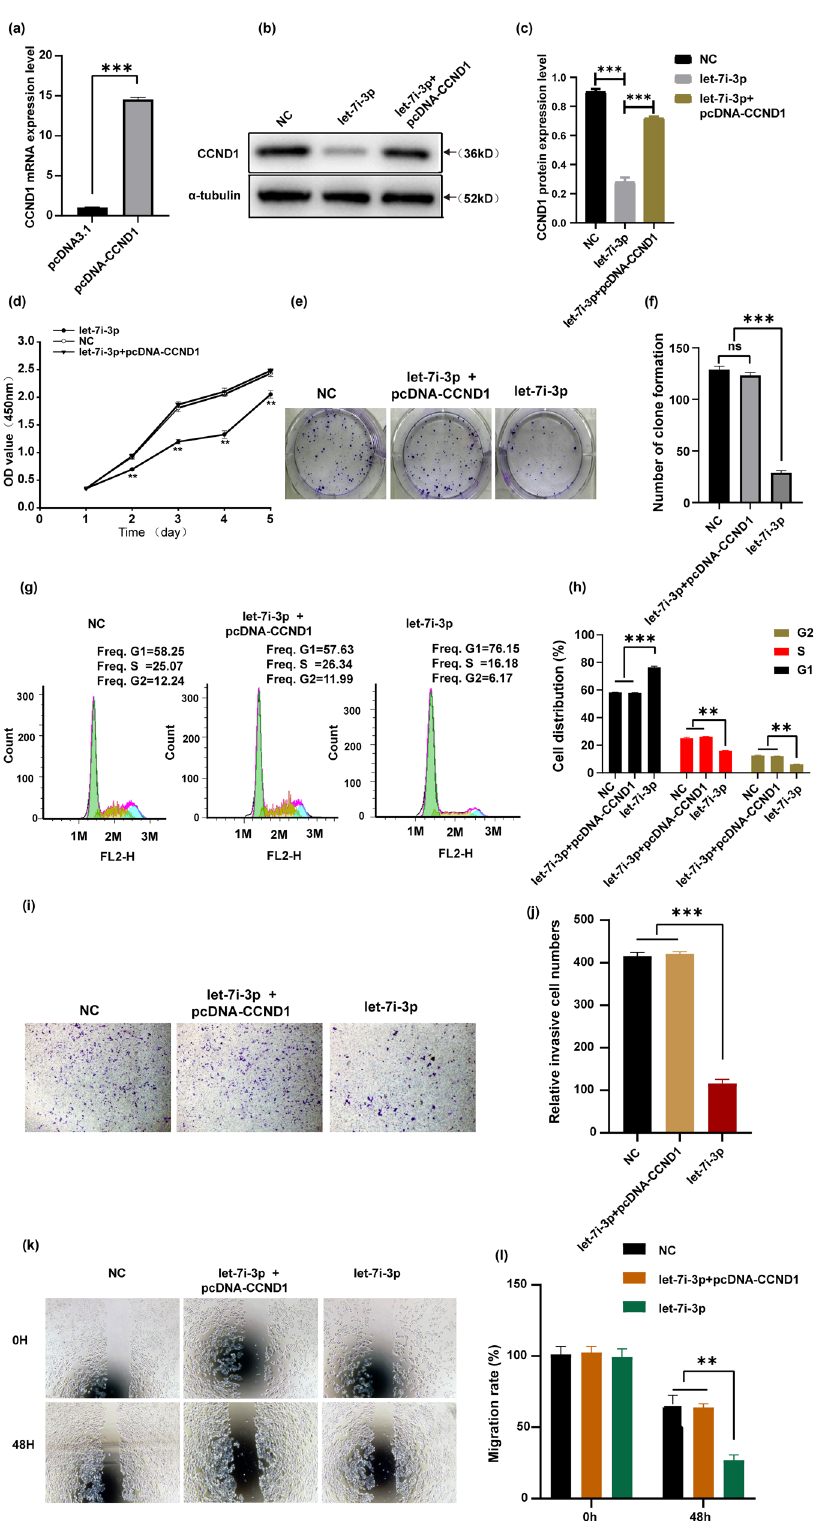
Figure 5: Overexpressed CCND1 could reverse the e ff ects of let - 7i - 3p on HCT116 cells. ( a ) The level of CCND1 mRNA expression was detected by RT - PCR. ( b ) The level of CCND1 protein expression was detected by western blot and a statistical histogram was shown at right ( c ) . ( d ) CCK - 8 assay was used to explore the proliferation of HCT116 cells. ( e ) A colony formation assay was conducted to verify that ectopic CCND1 expression could reverse proliferation induced by let - 7i - 3p overexpression in HCT116 cells and a statistical histogram was shown at right ( f ) . ( g ) Cell cycle distribution was measured by fl ow cytometry and a statistical histogram was shown at right ( h ) . ( i ) Transwell assay was carried out to con fi rm the e ff ects of CCND1 alteration in the invasion of HCT116 cells and a statistical histogram was shown at right ( j ) . ( k ) The change in cell migration was examined by wound - healing assay in HCT116 cells and a statistical histogram was shown at right ( l ) . * P < 0.05, ** P < 0.01, and *** P <